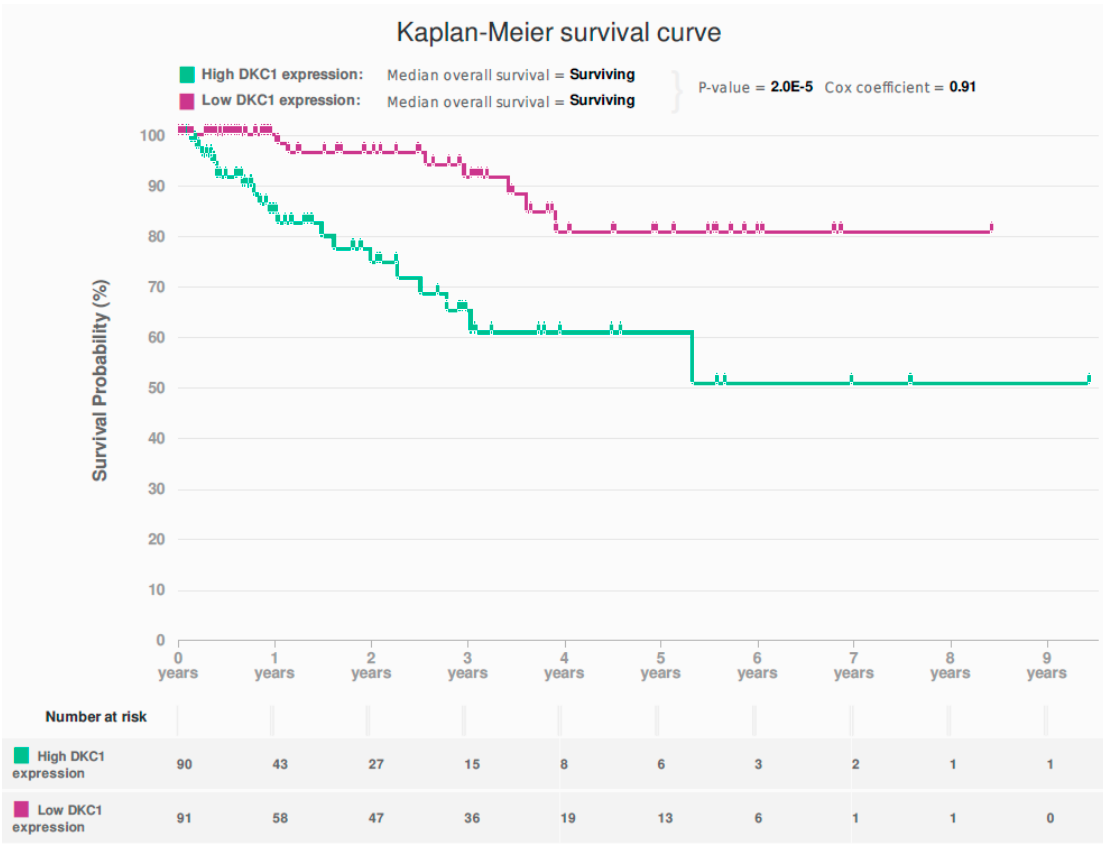
Figure 1. Kaplan-Meier survival curve for the association between DKC1 mRNA levels and overall survival ( p = 2 × 10 − 5, Cox-regression = 0.91) in The Cancer Genome Atlas (TCGA) dataset (endometrioid and serous endometrial cancer) { n = 477}.